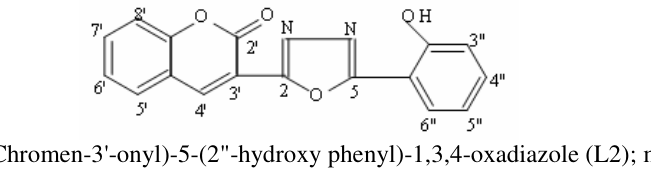
Figure 1 . Chromen-2-one-3-carboxy hydrazide (L1); m.p. 136º